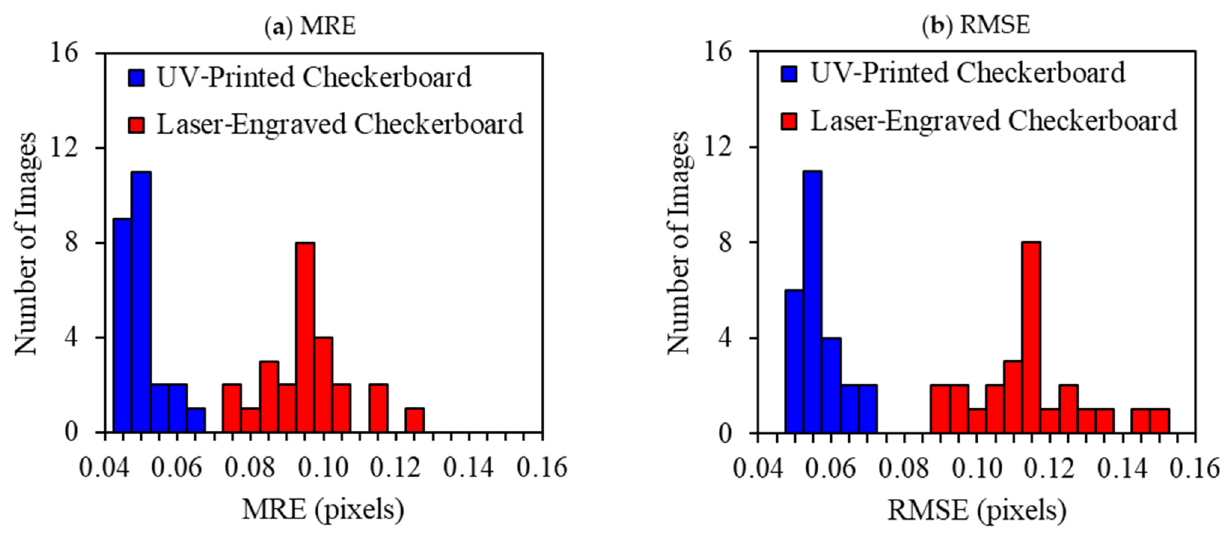
Figure 10. Histogram of ( a ) mean reprojection errors ( MRE ) and ( b ) root mean square errors ( RMSE ) of reprojection, using thermal images of calibration trial number 9 per selected checker- boards. Table 5. List of reprojection errors (MRE and RMSE) for the two calibration targets.